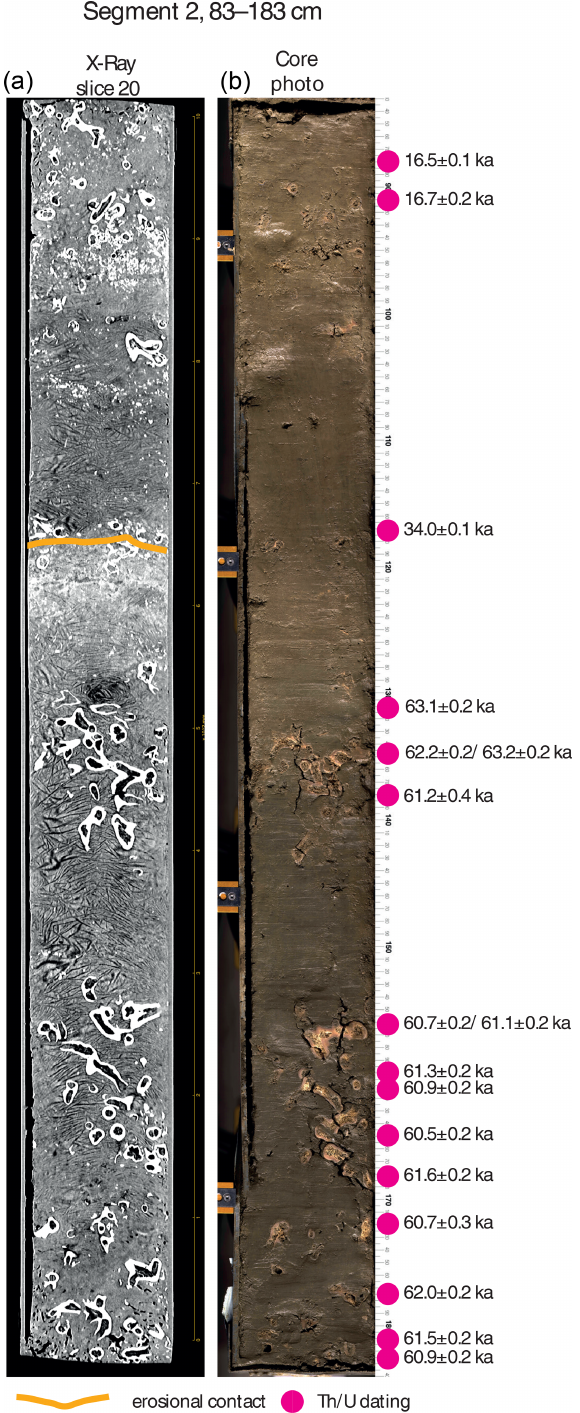
Figure B1. CT image (a) and photography (b) of segment 83–183cm of core M125-34-2. Erosional contacts are marked by thick black lines; position of Th / U datings with calibrated ages are indicated by magenta